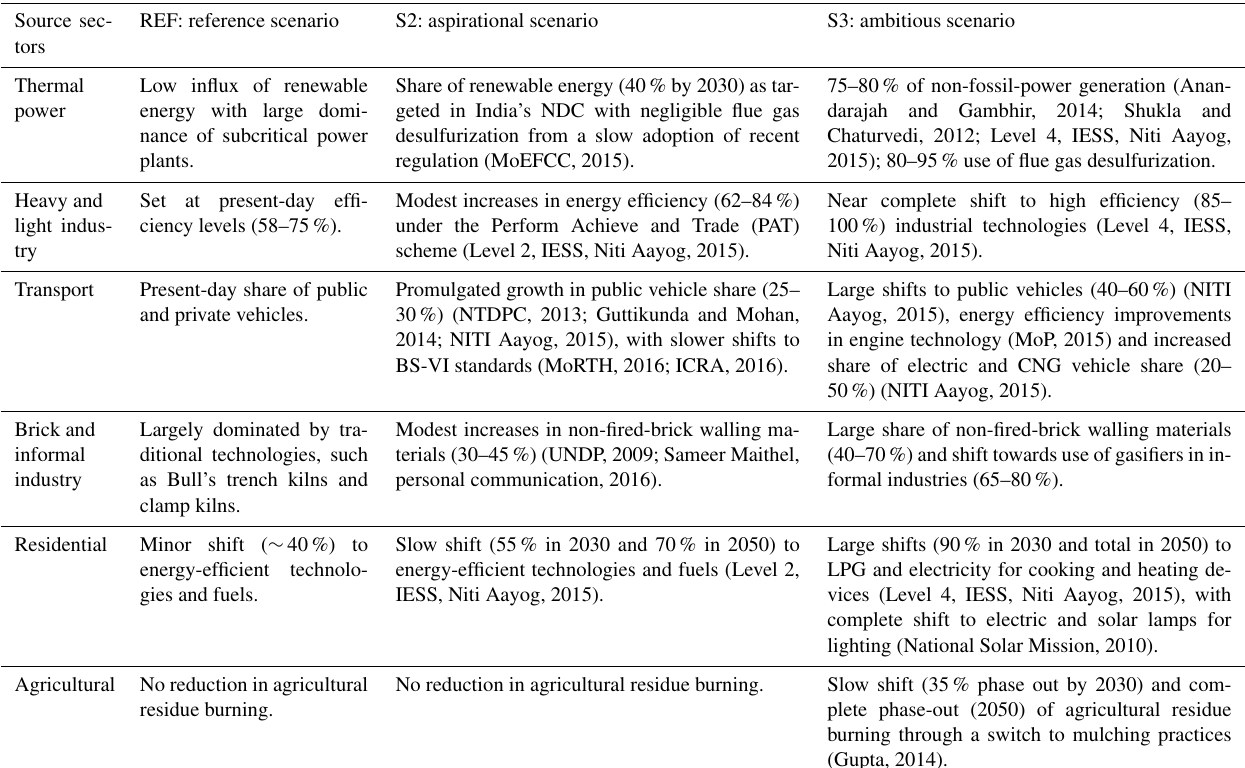
Table 2. Description of future